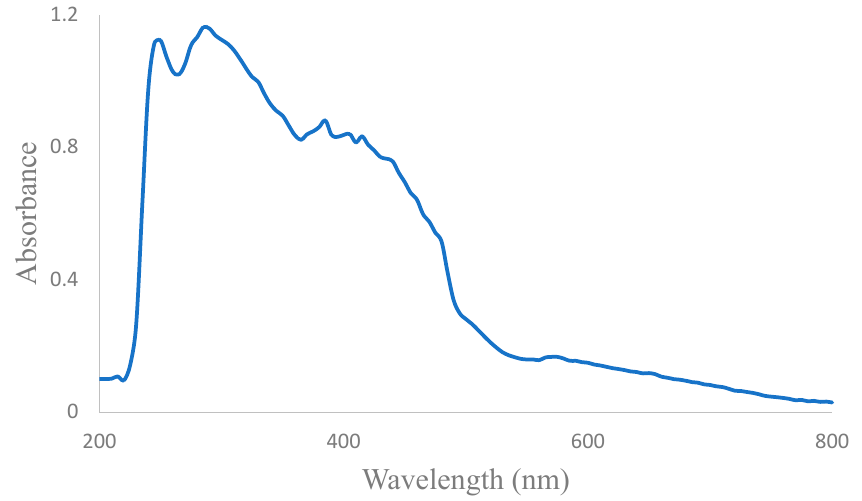
Figure 5. Experimental UV spectra of DNSPA. Table 2 . Selected computed wavelength (nm), oscillator strength (f), and main orbital transition contributions ( ≥ 20%) of the absorption spectra of DNSPA.